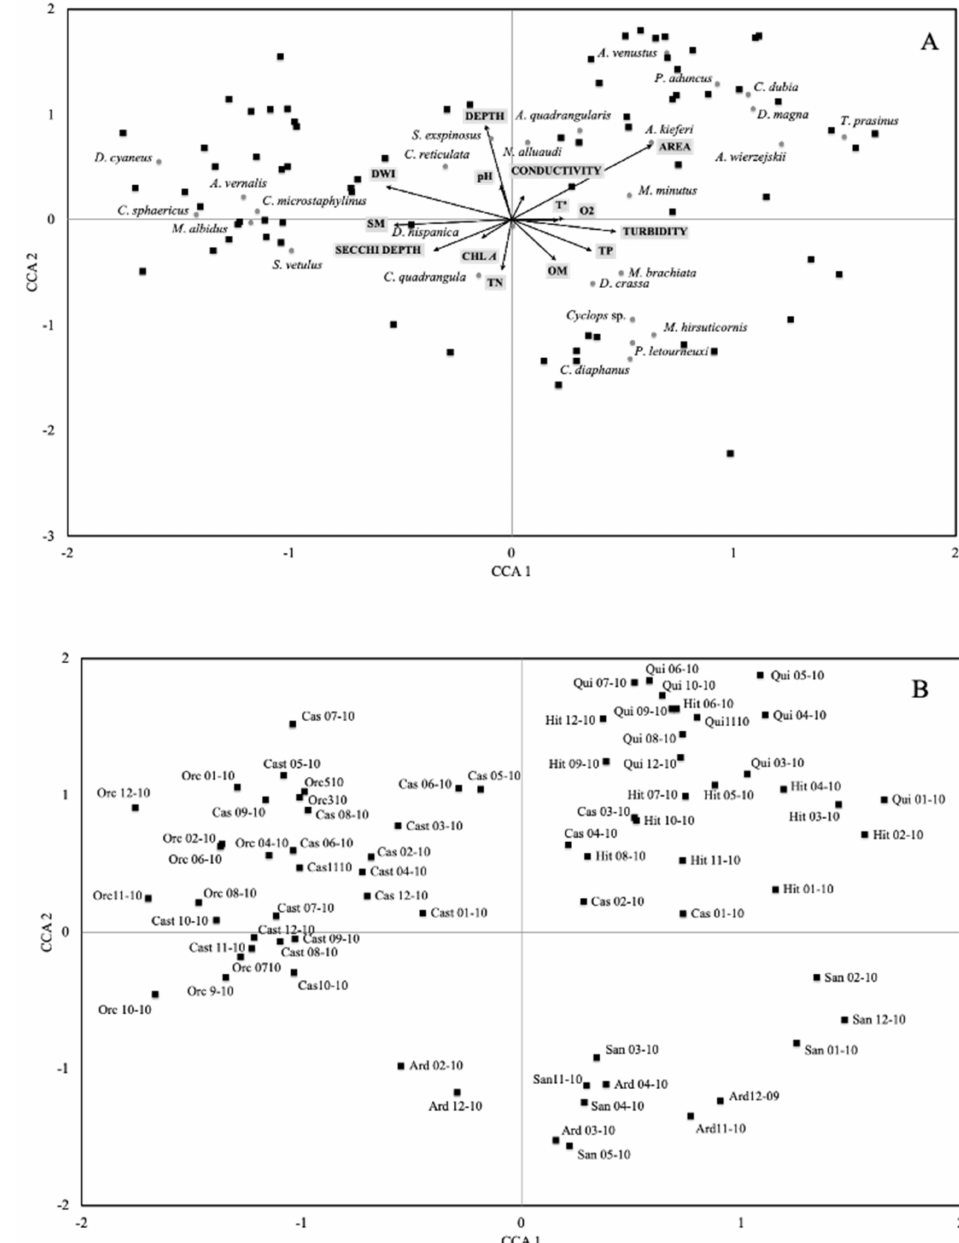
Figure 2. CCA ordination diagram. ( A ) Biplot showing the position of all samples (black squares); the zooplankton taxa (grey circles) and the environmental variables (arrows) in the plane of the first two axes. ( B ) Biplot showing the position of all samples (each pond and date - month and year in numbers) in the plane of the two first axes (Orc: Orcera; Cas: Casillas; Cast: Castillo; Hit: Hituelo; San: Santisteban; Orc: Orcera; Ard: